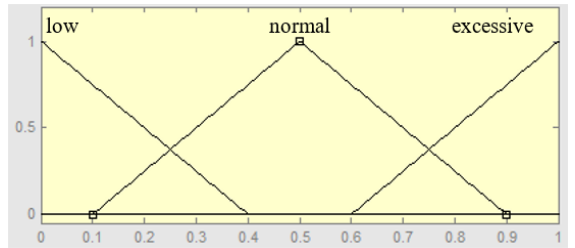
Figure 7. Membership functions of the use-horn fuzzy variable.